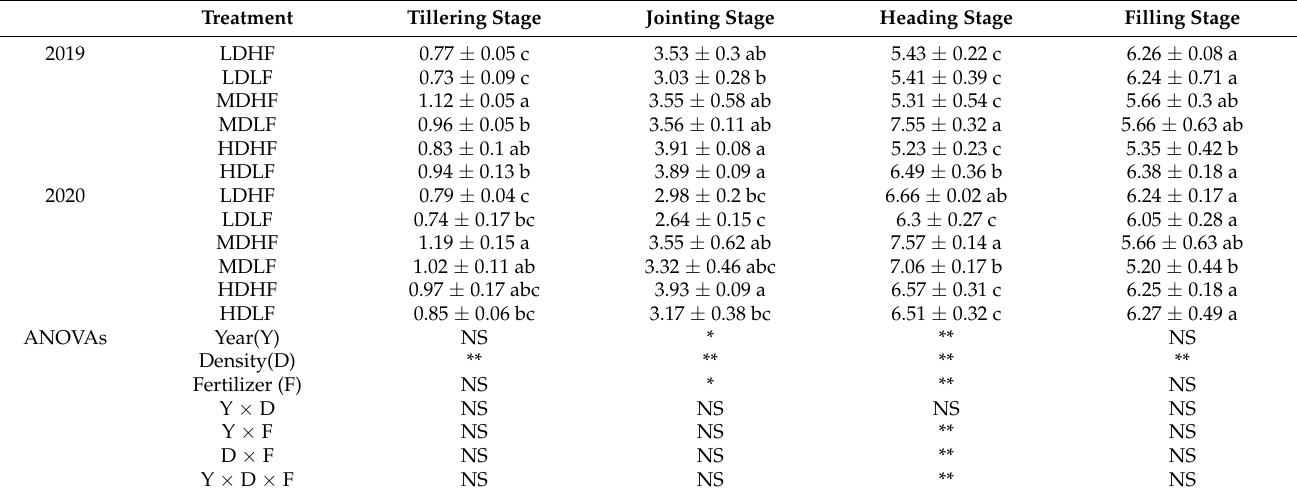
Table 4. Leaf area index (LAI) in different growth stages of rice under different treatments in